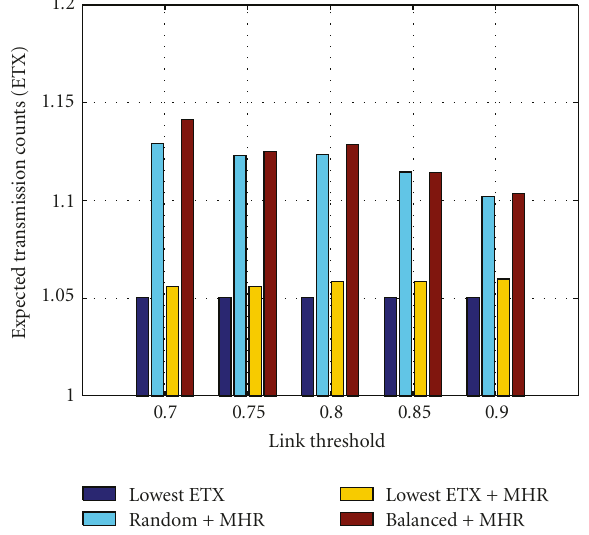
Figure 3: The comparison of localized tree construction schemes: the average ETX of data-gathering paths with respect to link